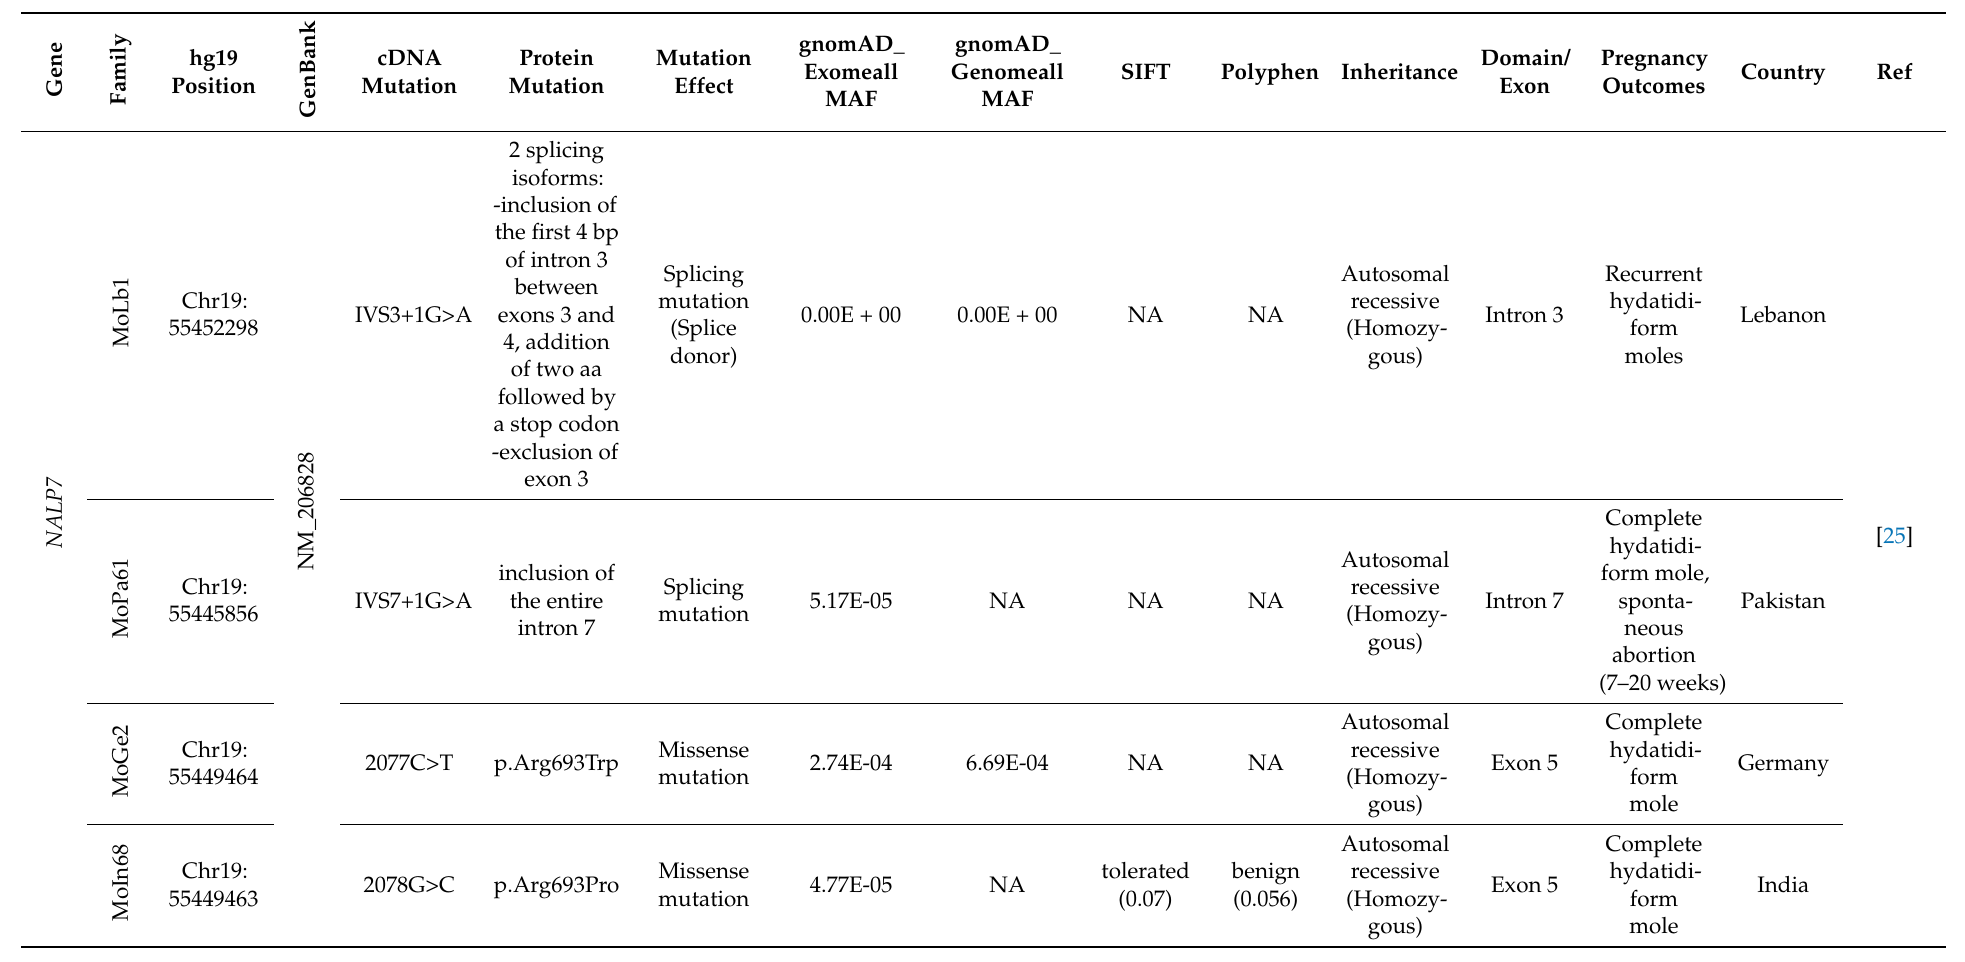
Table 1. Summary of familial and singleton variants within SCMC genes causing early embryonic lethality, MLID, and